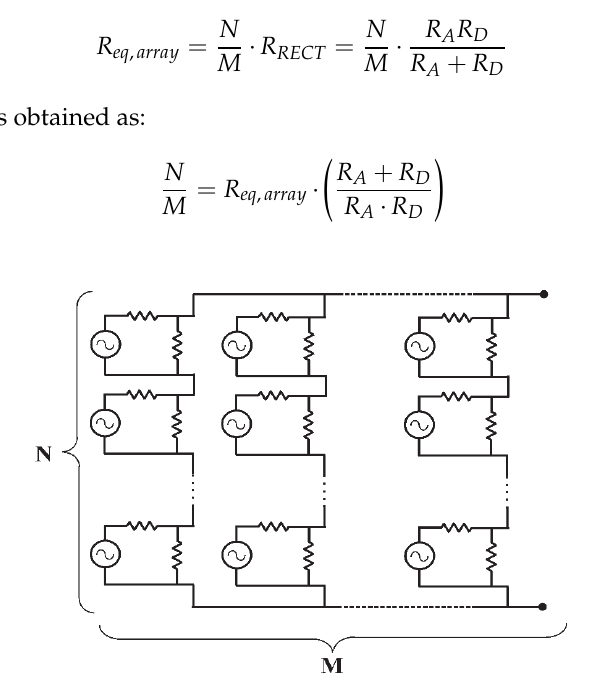
Figure 15. Equivalent circuit of an array of N·M optical rectennas, each cell corresponds to the circuit in Figure 14.